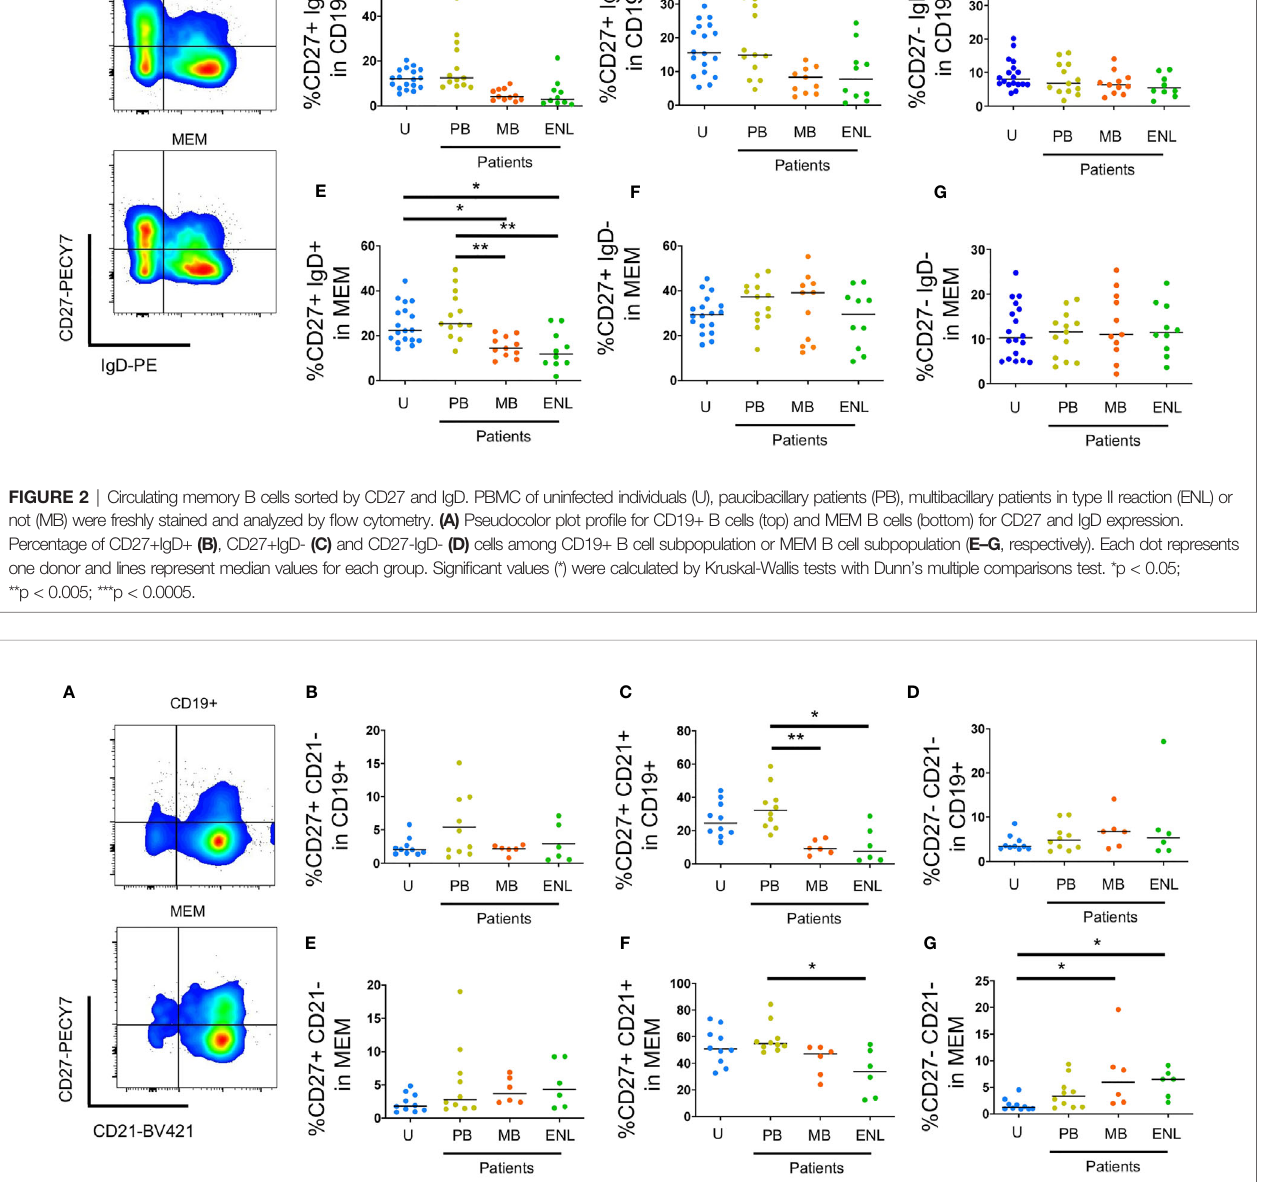
FIGURE 3 | Circulating B cells sorted by CD21 and CD27. PBMC of uninfected individuals (U), paucibacillary patients (PB), multibacillary patients in type II reaction (ENL) or not (MB) were freshly stained and analyzed by fl ow cytometry. (A) Pseudocolor plot pro fi le for CD19+ B cells (top) and MEM B cells (bottom) for CD21 and CD27 expression. Percentage of CD27+CD21- (B) , CD27+CD21+ (C) , and CD27-CD21- (D) cells among CD19+ B cell subpopulation or MEM B cell subpopulation ( E – G , respectively). Each dot represents one donor and lines represent median values for each group. Signi fi cant values (*) were calculated by the Kruskal-Wallis test with Dunn ’ s multiple comparisons test. *P < 0.05; **p < 0.005; ***p <